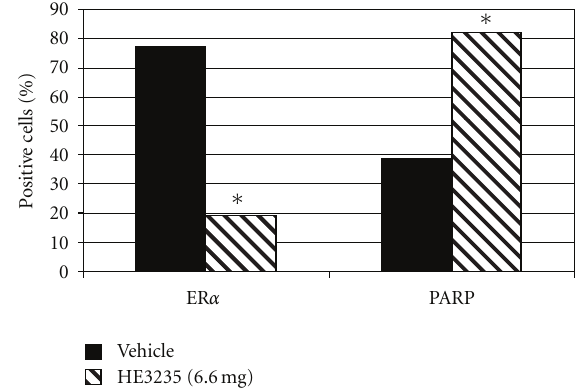
Figure 4: % Tumor cells positive for ER α and PARP. Seven-week- old female Lewis rats were treated with a single IP injection of 50mg/kg MNU. Tumors developed for 90 days, prior to treatment ( n = 10) for 14 days with cyclodextrin vehicle daily, or 6.6mg HE3235 daily. Para ffi n sections of tumors were examined for histopathology and stained for immunohistochemistry with anti- bodies to PARP or ER. HE3235 treatment increased the frequency of cells staining positive for the apoptotic maker, PARP, and decreased the frequency of ER α , which is associated with tumor survival. ∗ P < .